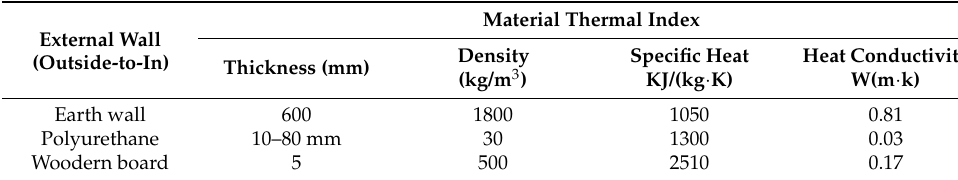
Table 7. Material settings of the exterior wall